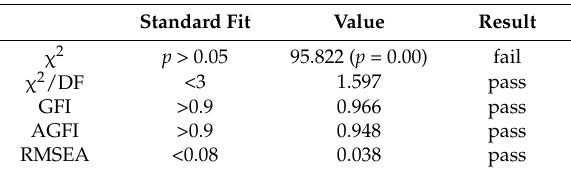
Table 4. The test of model fit.